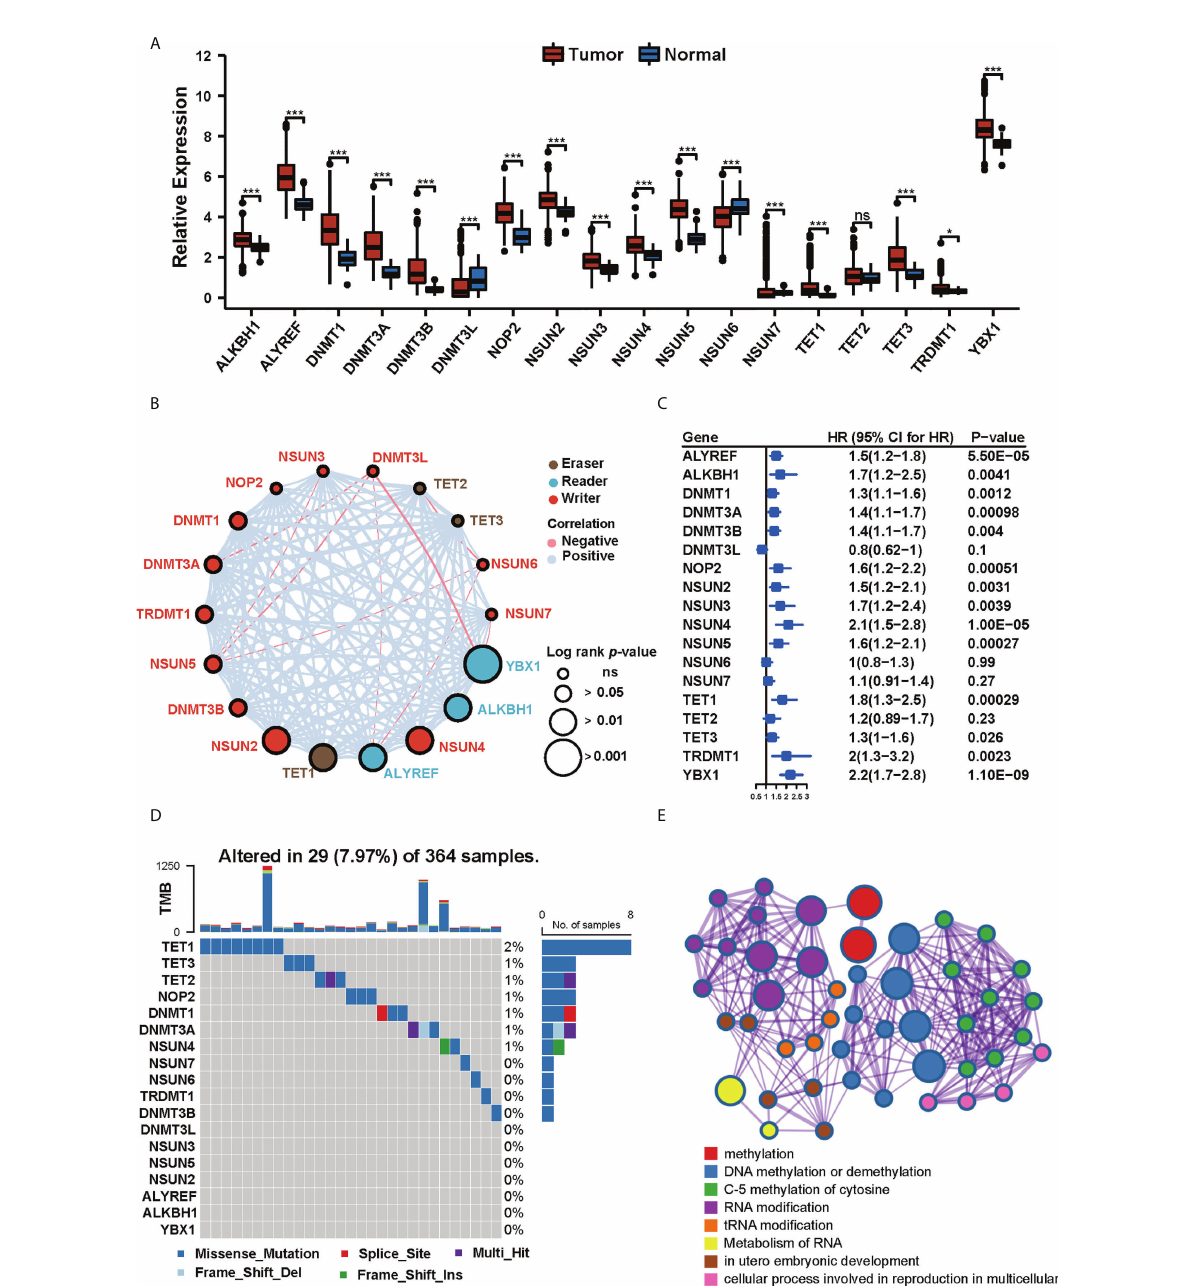
FIGURE 2 The landscape of expression and genetic variation of m 5 C regulators in HCC. (A) The expression pro fi les of m 5 C regulator genes in tumor tissues and normal tissues in TCGA-LIHC cohort. (* p<0.05, *** p<0.001, ns: no signi fi cant difference). (B) The interactions of 18 m 5 C regulator genes and their prognostic value. (C) Univariate Cox regression analysis of the 18 m 5 C regulator genes in patients from TCGA-LIHC cohort. (D) The mutation frequency of 18 m 5 C regulators in 364 patients from the TCGA-LIHC cohort. (E) Metascape enrichment network visualization of 18 m 5 C regulators. Cluster annotations were shown in the color